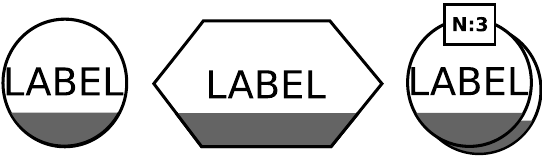
Figure 2.5: The Process Description glyph for simple clone marker applied to a simple chemical , an phenotype and a multimer of simple chemicals